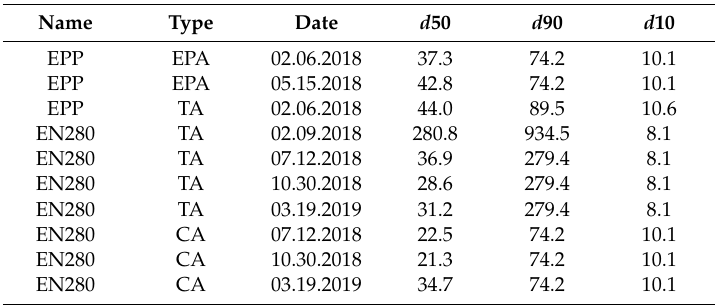
Table A1. Particle size distribution of EPP and EN280 ashes ( d 50, d 90, d 10).